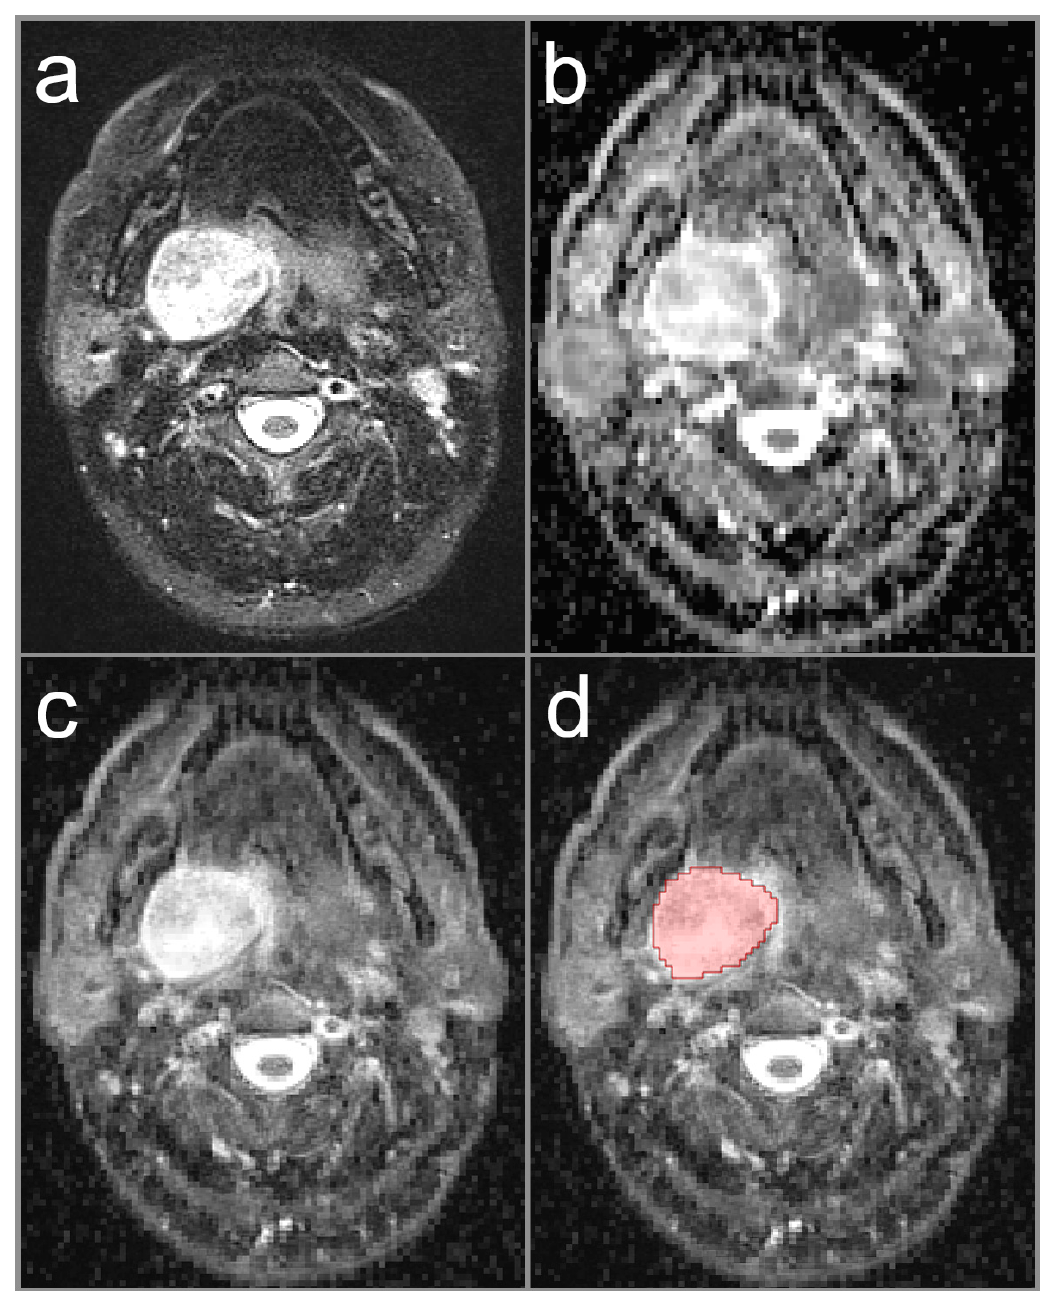
Figure 1. Image illustrating a study patient with pleomorphic adenoma in the deep lobe of the right parotid gland (red area indicates lesion on this particular slice). The image on the left upper row ( a ) shows the T2-weighted image with fat saturation, clearly delineating the tumor boundaries. The image on the right upper row ( b ) displays the parametric ADC map. The image on the left lower row ( c ) illustrates the co-registration of the ADC map and T2-weighted image with a mix ratio of 50%. The image on the right lower row ( d ) shows the co-registered image with the region-of-interest illustrated.